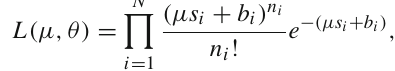
σ × BR from a model of second generation LQs decaying into a μ − μ + c ¯ c final state with coupling y μ c =